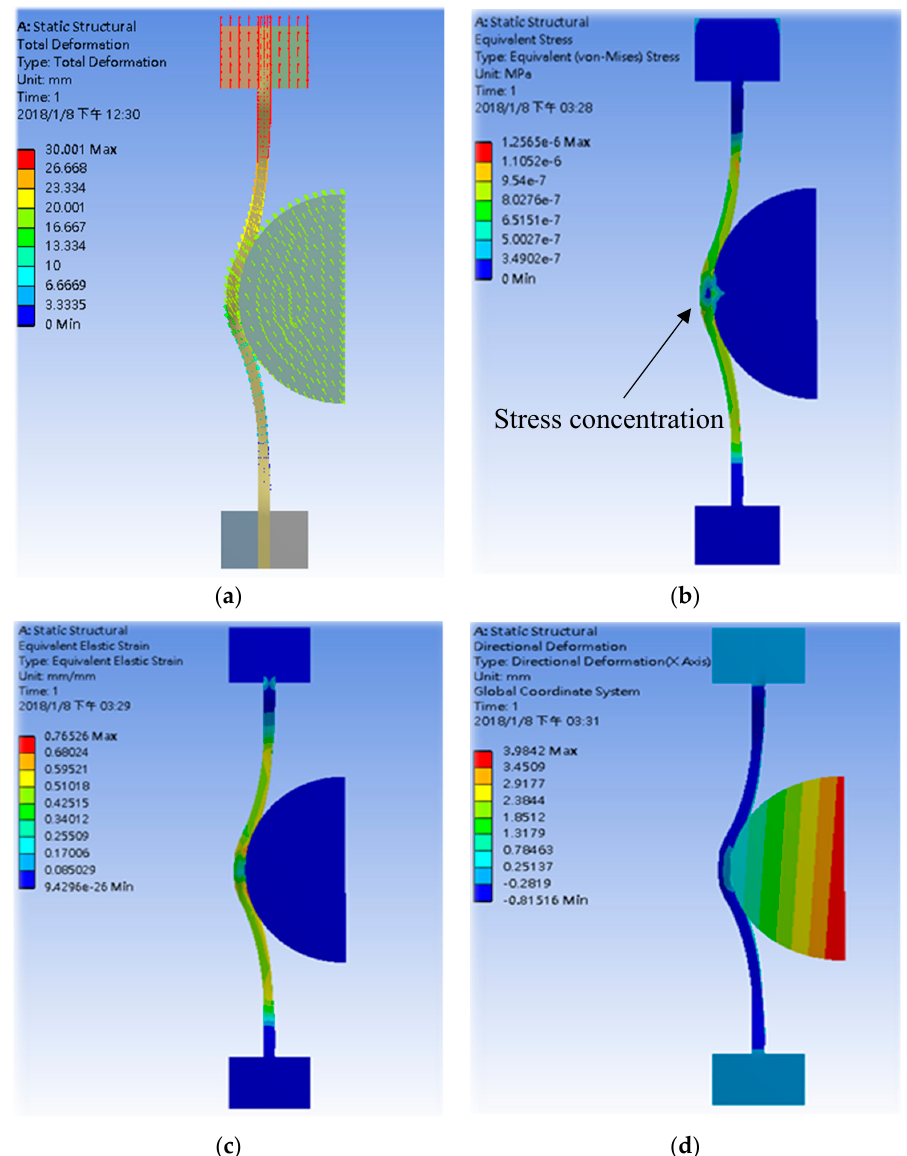
Figure 4. ( a ) Total deformation; ( b ) Von-Mises stress; ( c ) Equivalent elastic strain; ( d ) Directional deformation Simulation analysis diagram.